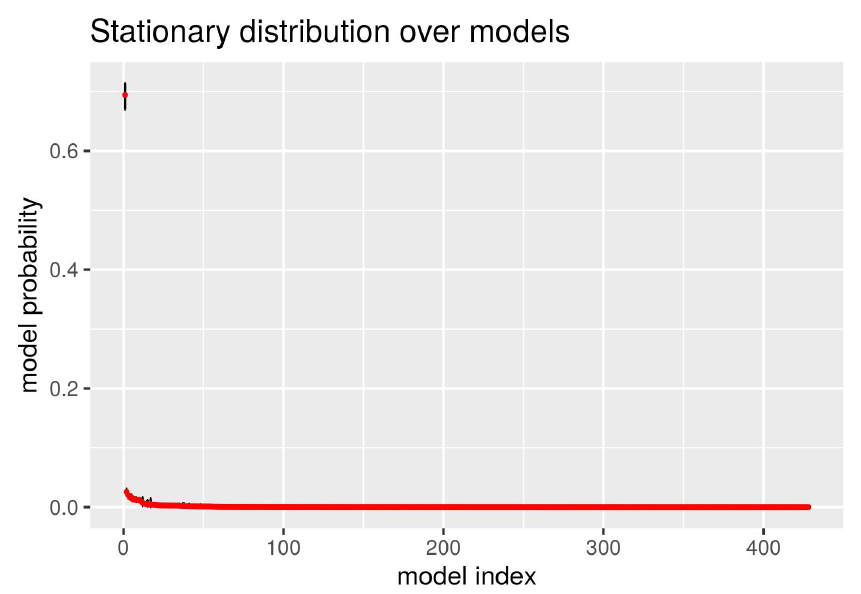
Figure 7. Stationary distribution over the models encountered in the chains produced by the sampler. Red points represent the median and the black bars represent the range between the 5th and 95th percentile. The model labels were assigned again after the posterior evaluation so that they are sorted in descending order. The distinction between the first and the rest of the models is visible and holds even with respect to the